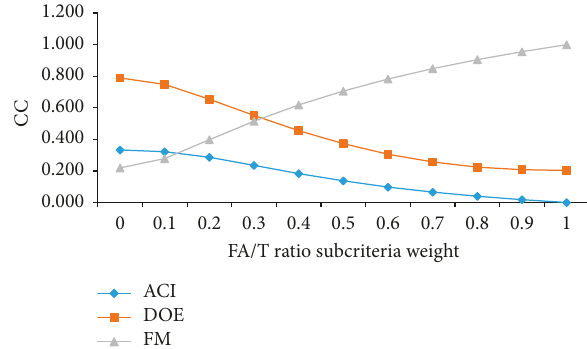
Figure 9: Sensitivity analysis of mix design methods with respect to FA/c weight.